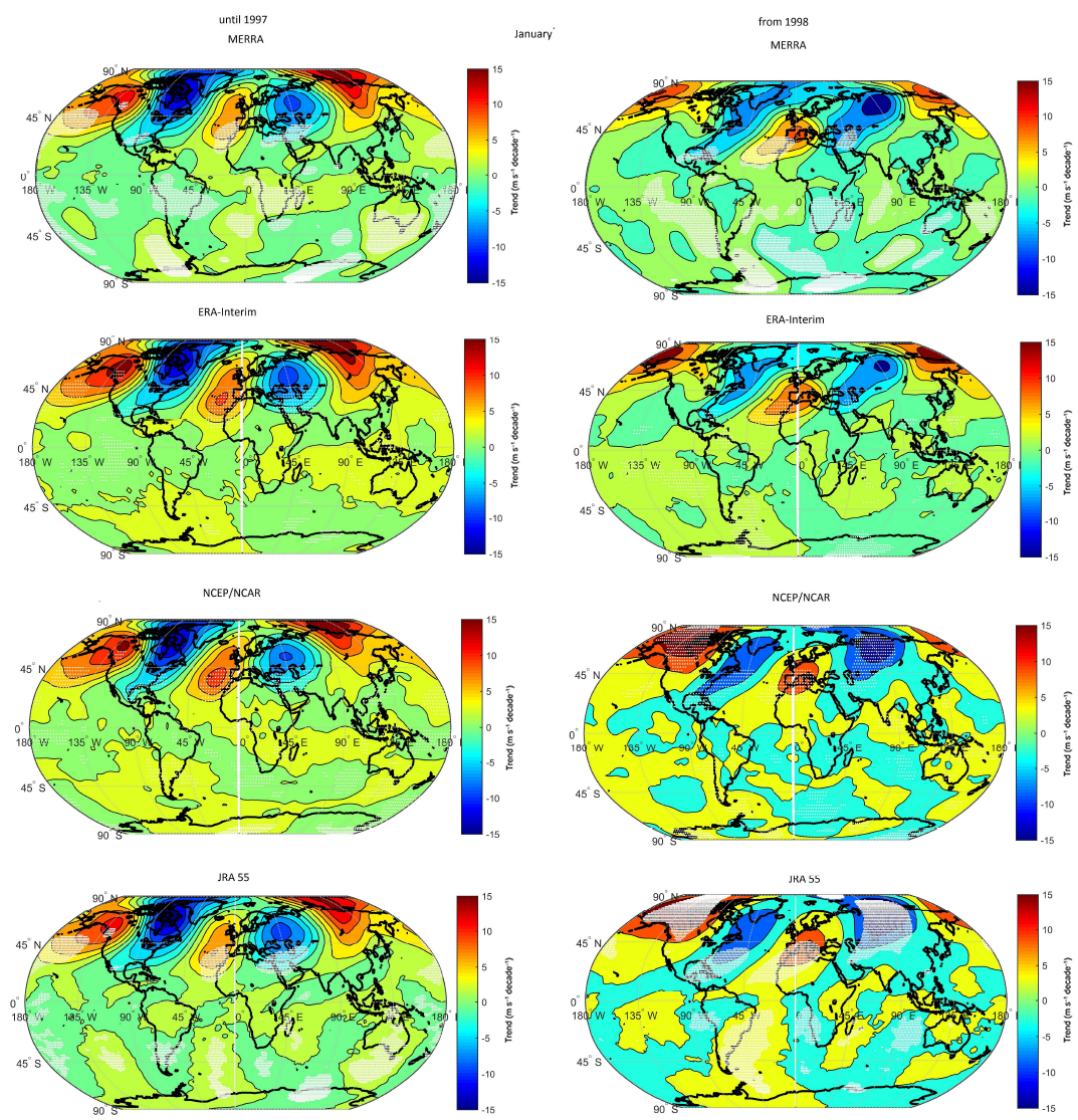
Figure 7. The same as Fig. 6 but for December. Statistical significance (95%) is highlighted by white